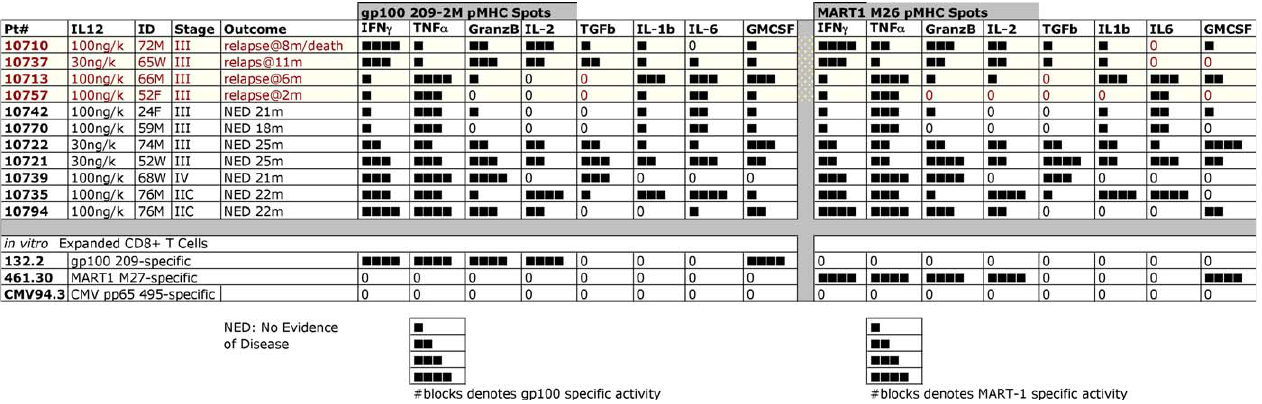
Figure 5. Heterogeneity of Melanoma-Associated Antigen-Specific T Cell Responses following Peptide Vaccination Eleven samples taken from patients enrolled in peptide vaccine trials were analyzed on pMHC functional microarrays. Patients received eight subcutaneous injections of peptides gp100 209–2M, MART1 M26, and tyrosinase 370D, along with adjuvant in a 6-mo period. Leukopheresis samples were collected after the eighth injection. Sample 10794 was collected from the same patient as 10735 after month 12. Functional profiles were generated by incubating patient CD8 þ T lymphocytes on pMHC functional microarrays for 24 h at 37 8 C and detecting the secreted factors